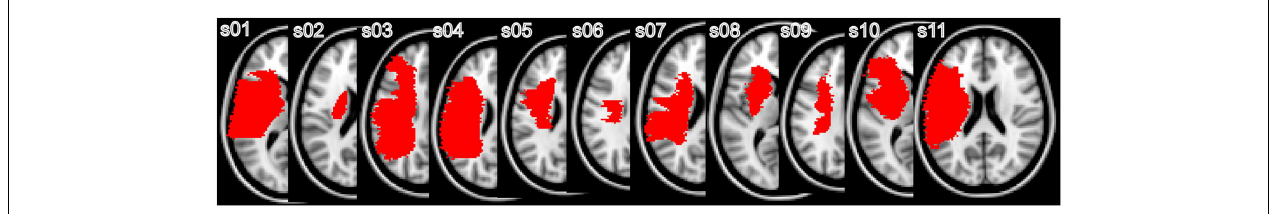
FIGURE 1 | Representative individual lesion maps: individual lesion maps are superimposed on the MNI standard template .The slice closest to the internal capsule level with the greatest lesion is shown.